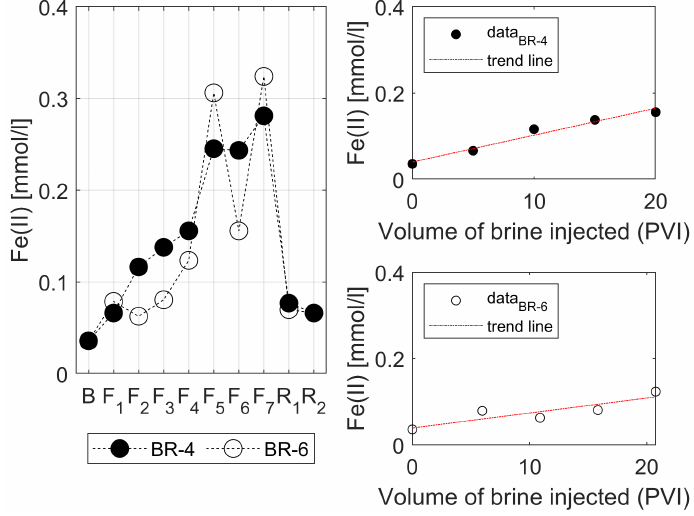
Figure 9. Fe(II) concentration in Bandera Brown core plugs flooded with 2D*TB EDTA and trend lines. The injection of 2D*TB EDTA through the heterogeneous PR-3 and PR-6 sandstone core plugs gives the Fe(II) changes shown in Figure 10. The changes in the iron concentration for those rocks are also increasing during the forward injection, reaching a maximum of 0.3 mmol/L. Notice that a longer discontinuity in the injection (1 h 30 min) resulted in a higher Fe(II) concentration. This could be because EDTA had more time to chelate with the iron from the rocks, which was transported by the injection fluid afterward. The Parker sandstone core plugs also showed a similar constant concentration (0.07 mmol/L) as the Bandera Brown cores in the reverse injection.